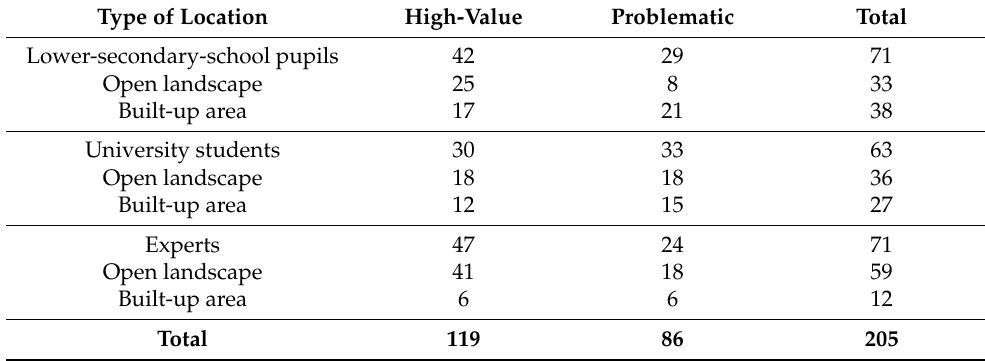
Table 1. High-value and problematic locations in the model region mapped by different groups. Type of